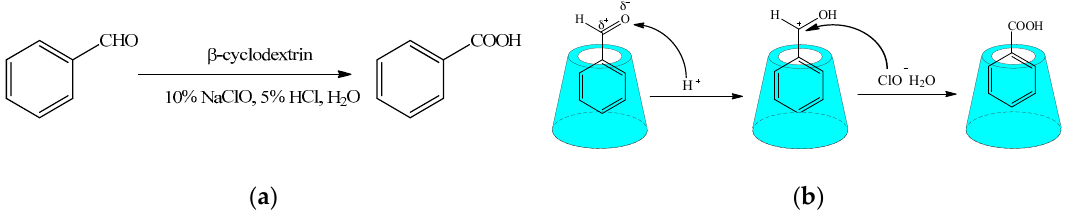
Scheme 4. ( a ) The oxidation reaction of benzaldehyde catalyzed by β -CD; ( b ) the proposed mechanism of the oxidation reaction of benzaldehyde to benzoic acid.